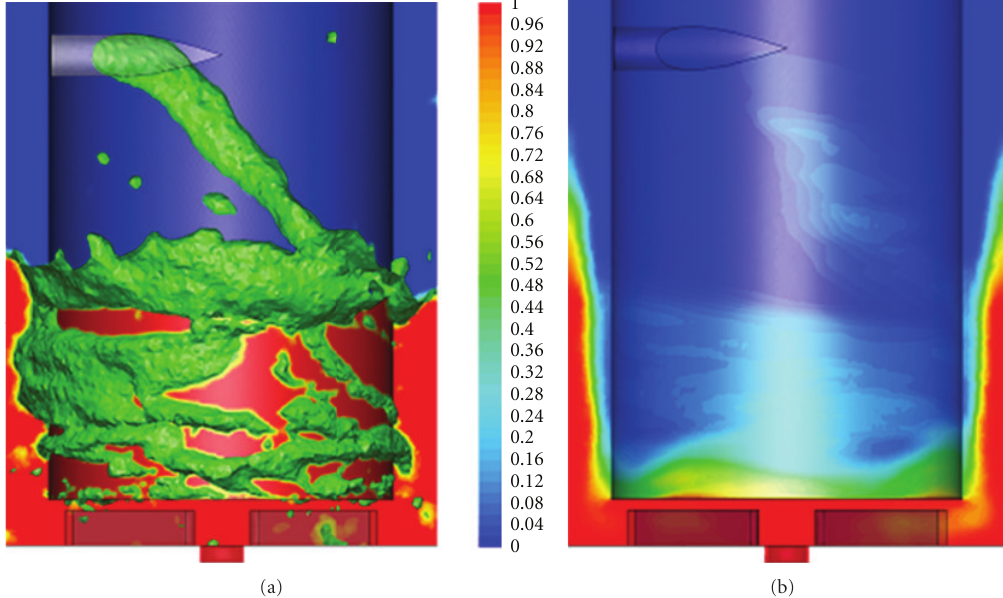
Figure 7: Snapshots of instantaneous (a) and time-averaged (b) liquid volume fraction for free-surface simulation of the annular mixing region with four straight housing vanes. Images are taken from Wardle et al. [143].